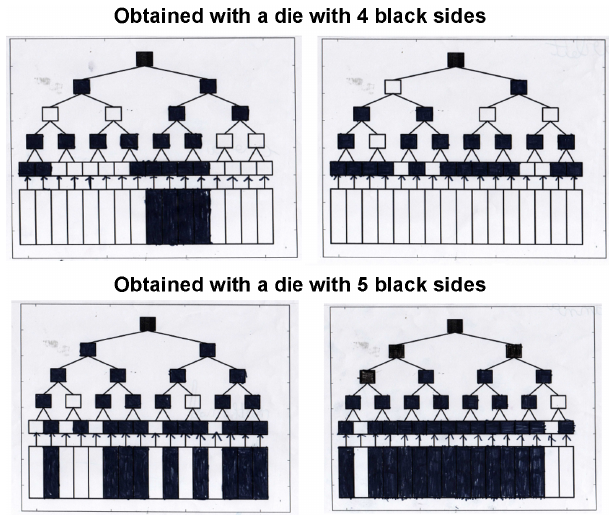
Figure 8. Examples of daily time series generated by the children with the β -model